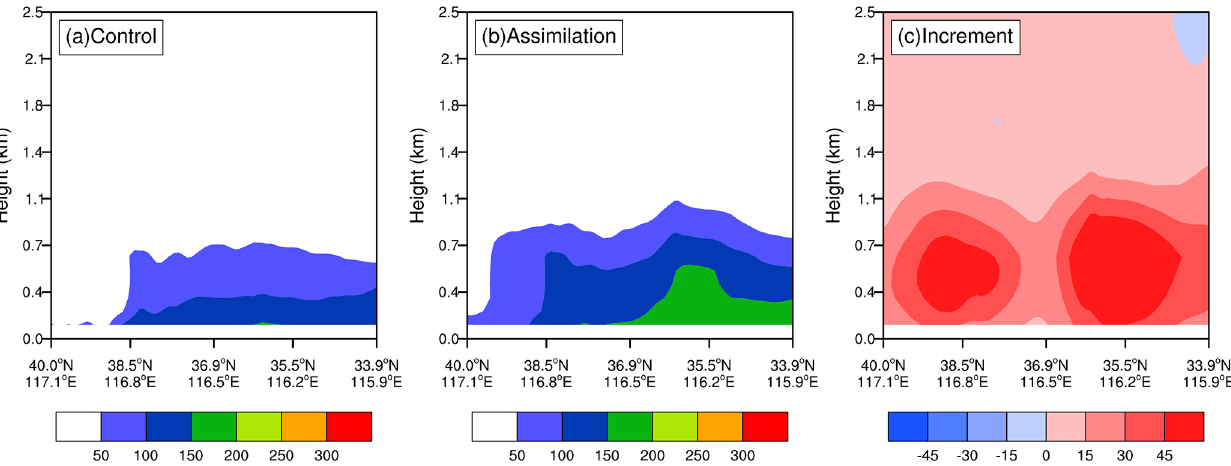
Figure 10. Vertical cross section of PM 2 . 5 in the background field (a) , analysis (b) , and the increment (c) in D02 at 03:00UTC on 25 Novem- ber